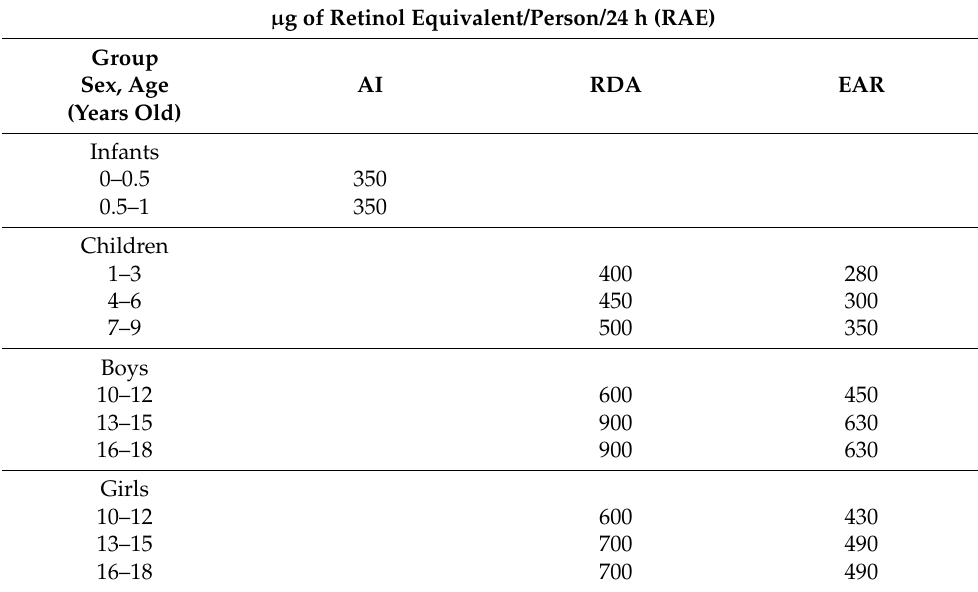
Table A1. Vitamin A—recommended dietary allowance (RDA) ; estimated average requirement